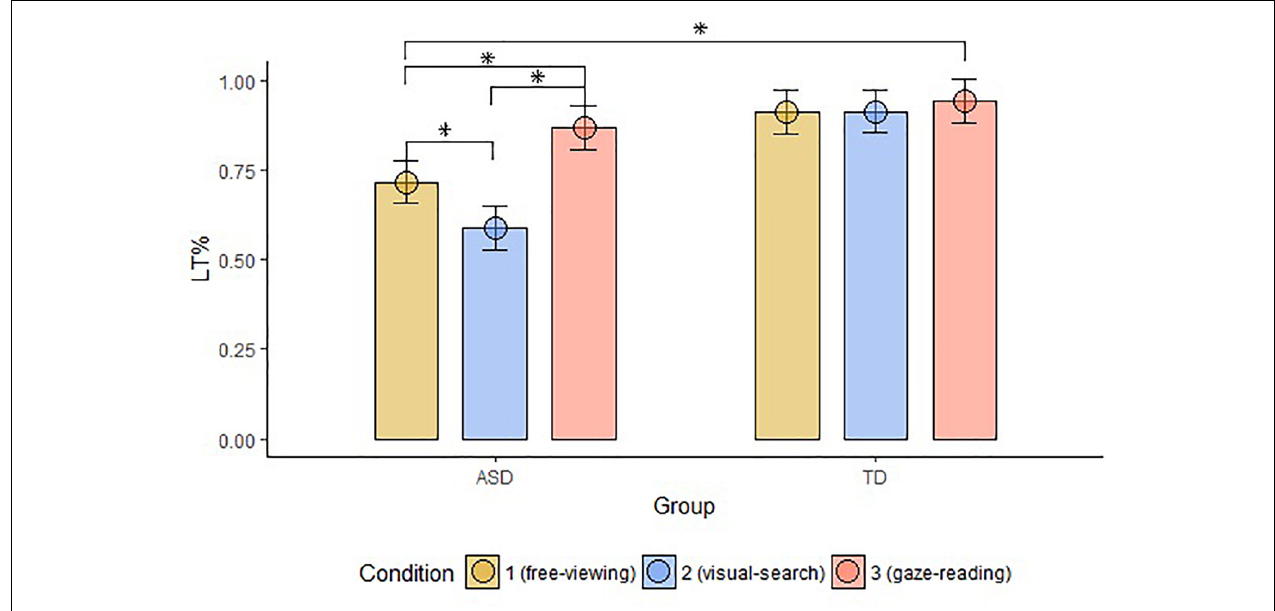
FIGURE 5 | Mean LT% on Face, compared to the other AOIs, across groups and conditions. The top bracket indicates between group comparisons. The additional three brackets indicate within groups comparisons (LT%, proportional looking-time on face; ASD, autism spectrum disorder; TD, typical development; ∗ , significant